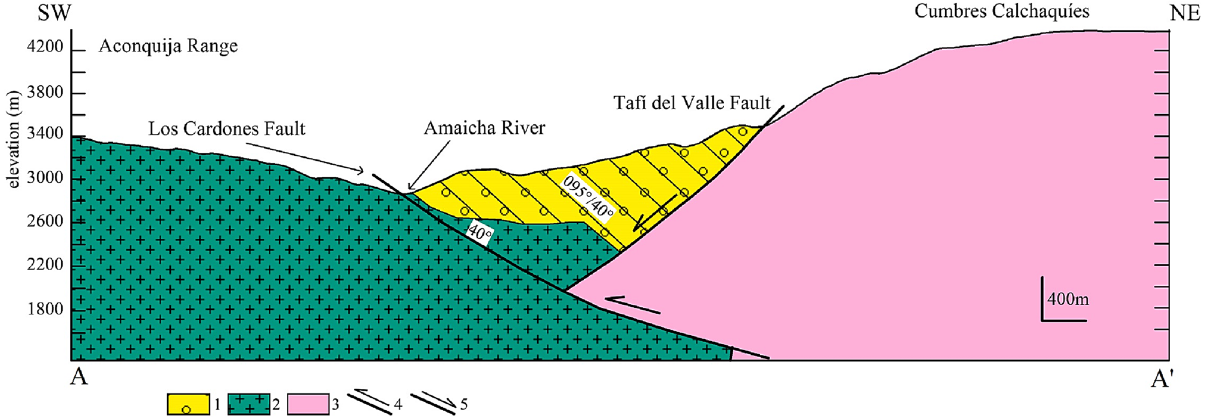
fault. 5: Normal fault. The Los Cardones fault zone has a general dip direction to the NE, dipping 40° (Fig.